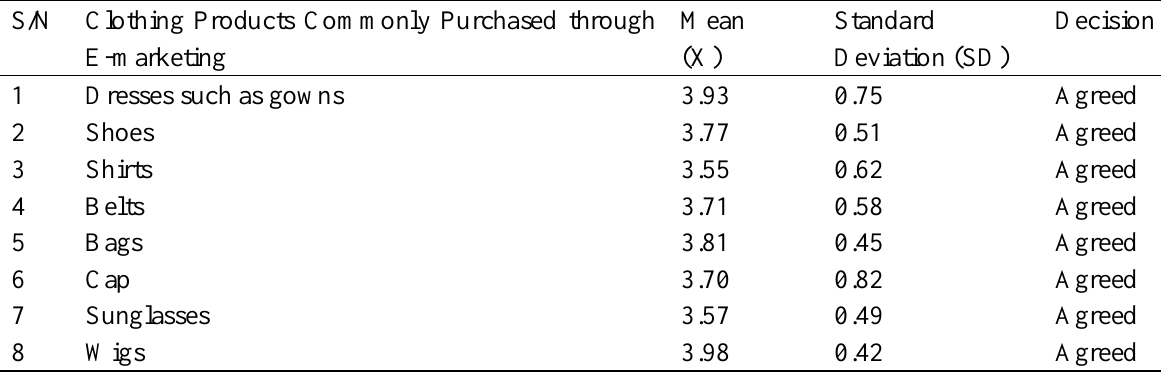
Table 1: Mean Rating and Standard Deviation Responses of Clothing Products Commonly Purchased through